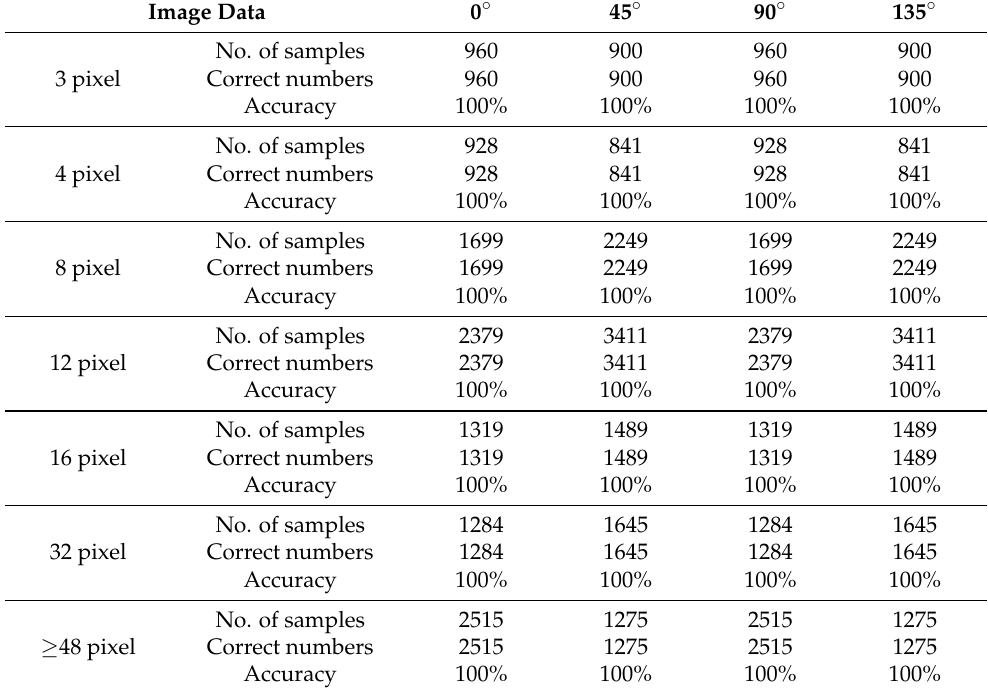
Table 1. Detection accuracy analysis of the AVS on binary image